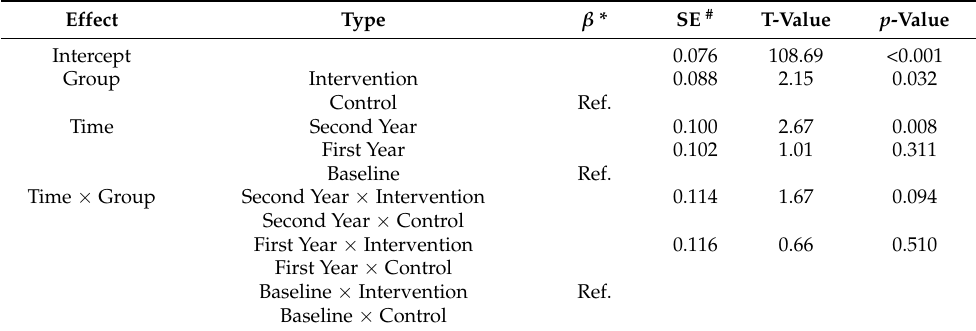
Table 8. Test of the fixed effects of various factors of dietary behavior score.